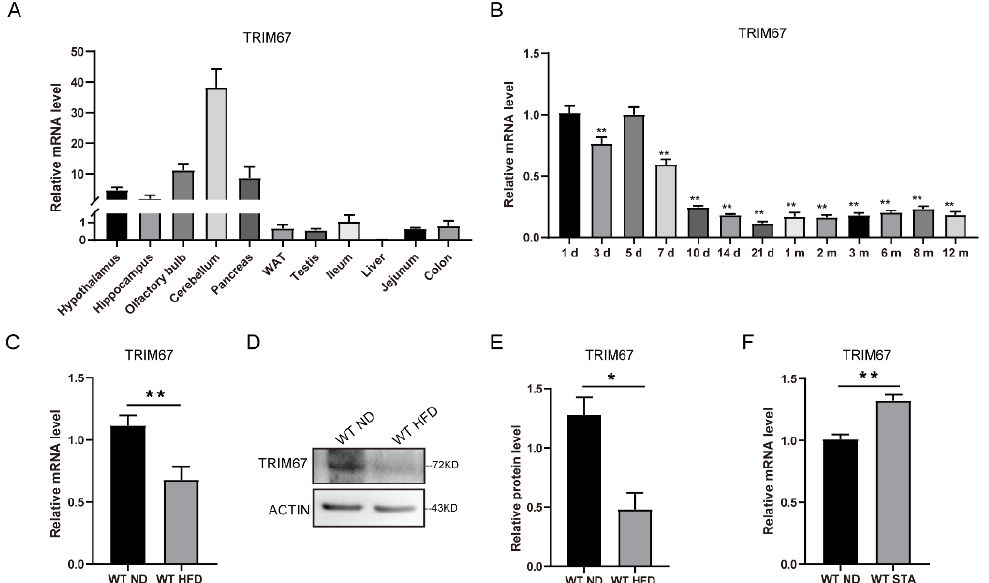
Figure 1. TRIM67 is responsive to energy homeostasis. ( A ) RT-qPCR analysis for the abundance of TRIM67 in different organs ( n = 4). ( B ) The expression levels of TRIM67 in hypothalamus tissues from the different ages of WT mice ( n = 4). ( C ) The expression of TRIM67 in hypothalamus of male mice after a 14-week high-fat diet ( n = 4). ( D ) The protein level of TRIM67 in hypothalamus of male mice after a 14-week high-fat diet ( n = 4). ( E ) The gray value statistical analysis of TRIM67 ( n = 4). ( F ) The expression of TRIM67 in hypothalamus after 24 h starvation ( n = 4). Four samples from each group were used for RT-qPCR analysis and two duplicate samples were measured. The data are presented as means ± SEM. * p -value < 0.05; ** p -value < 0.01.